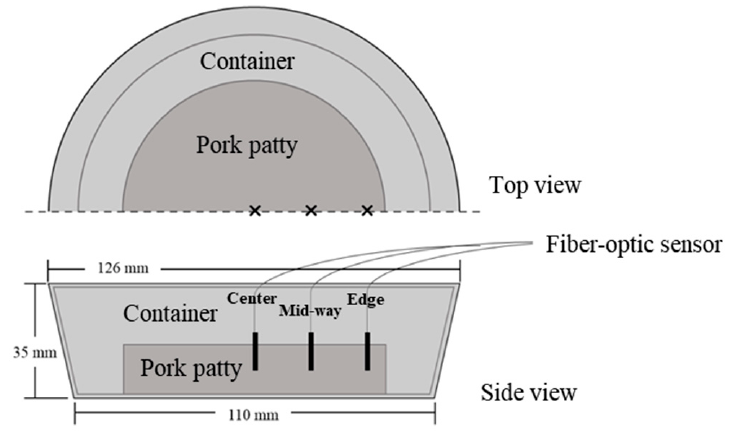
Figure 1. A schematic of the microwave tray showing the three sensor locations used to evaluate temperature distribution.